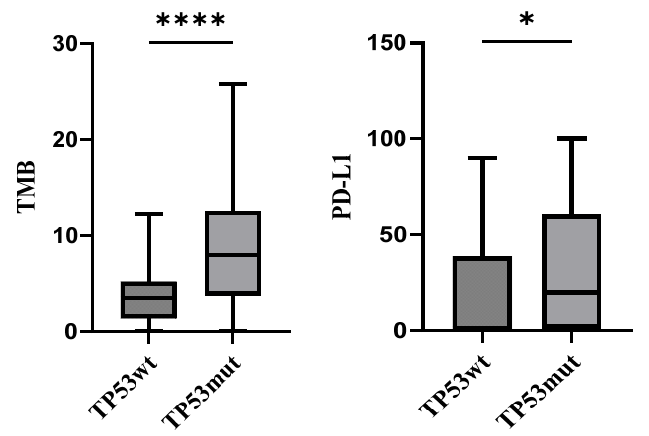
Figure 2. TMB and PD-L1 levels in TP53wt and TP53mut cohorts (* p < 0.1, **** p < 0.0001).